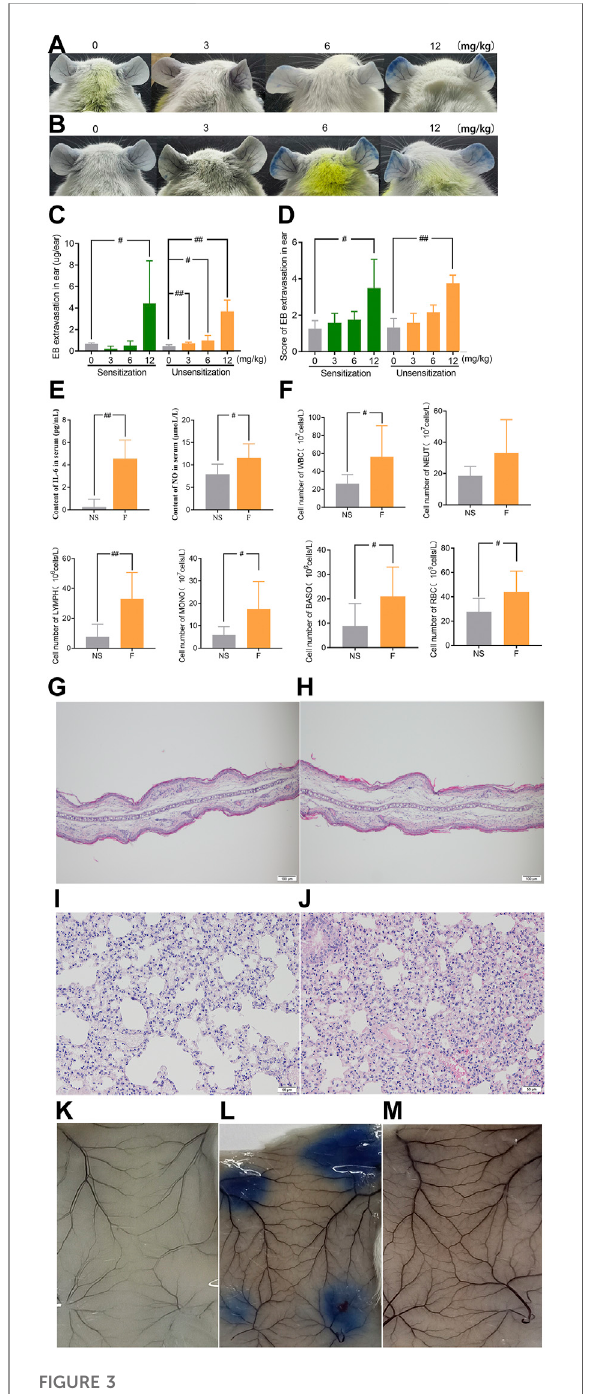
FIGURE 3 | penilloic acid(12 mg/kg). (I,J) Microscopicexamination of lungs ×200. (I) NS, (J) penilloic acid (12 mg/kg). (K – M) Representative image of EB extravasation of mice dorsal inboard skin induced by penilloic acid ( n = 3). (K) NS, (L) OVA, (M) penilloic acid (12